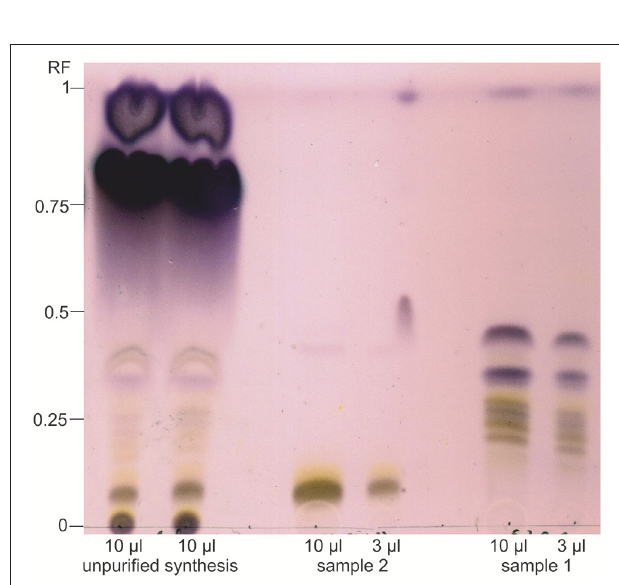
FIGURE 4 | Thin layer chromatography of synthesis products from the enzymatic reaction of microbial fatty acid methyl esters and beech wood cellulose fiber hydrolysate sugars catalyzed by iCalB in a DES reaction system. The crude synthesis extract, the purified and unified sample 1 and 2 were applied; sample 3, as middle fraction of sample 2, was not spotted and direct analyzed by NMR. After the run, the plate was dyed with anise aldehyde solution. Spots with RF 0 represents glucose (dark gray) and xylose (yellow) as leftovers from the DES. The light gray-yellowish spots between RF 0.05 and 0.42 indicate the formation of various fatty acid glucose- and xylose-esters. The high of the spots depends on the sugar, fatty acid chain length and saturation state. The two dark purple spots (RF 0.75 and 0.92) represents fatty acid methyl esters which were not consumed during the synthesis reaction.